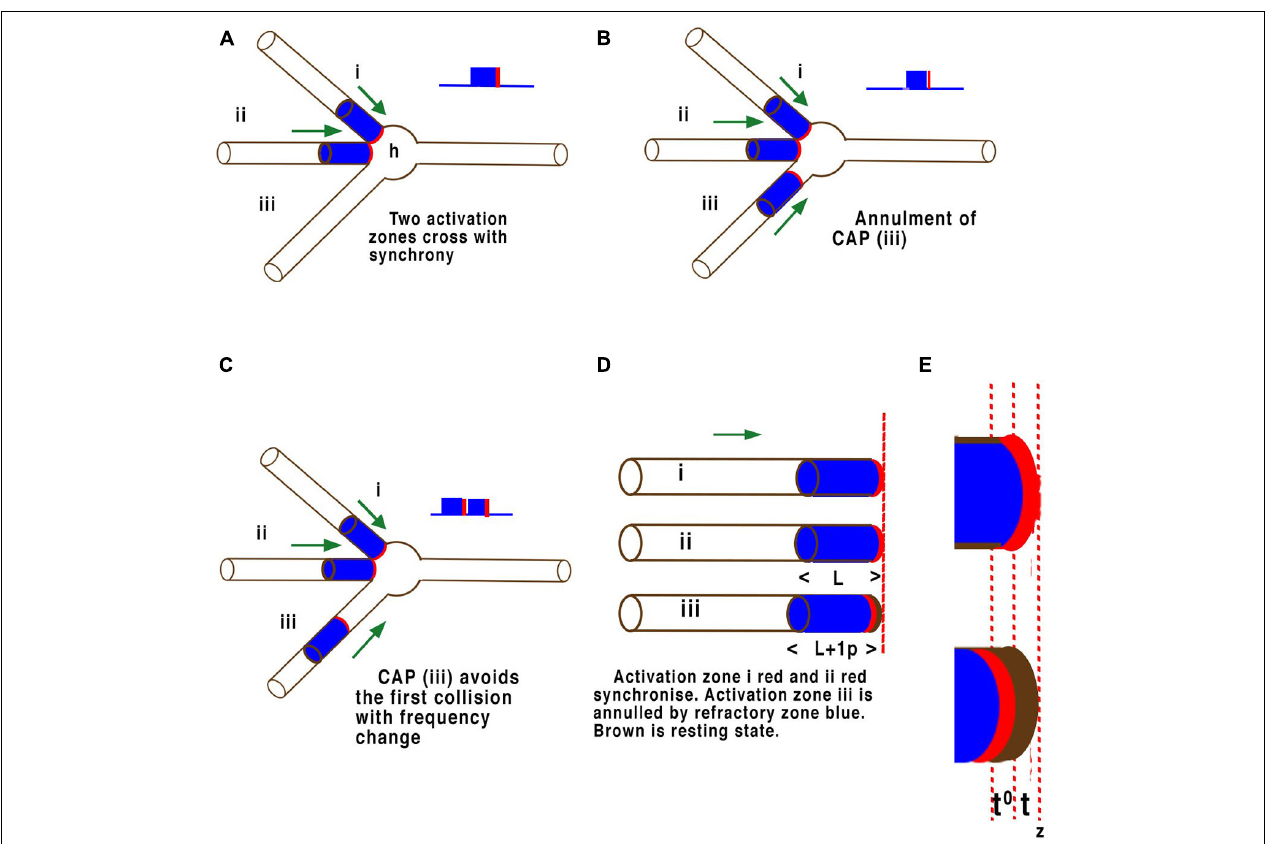
FIGURE 6 | Examples of quantum phase ternary interference between CAPs. Panels (A–E) are illustrations of CAP’s travelling along the surfaces of the neuron membrane just before collisions at the axon hillock (h). The threshold of each CAP is highlighted in red while the refractory period is coloured blue. These are not to scale. Panel (A) illustrates a single neuron with three axons converging on an axon hillock or cell body. Two CAP’s (i) and (ii), move in the direction of the axon hillock where they will collide. In this case both CAP’s (i) and (ii), are in phase with the thresholds overlapping. These CAPs will fuse and continue a single CAP. (B) The same two CAP’s (i) and (ii), are in phase with the thresholds overlapping and will fuse and continue as one CAP as in panel (A) , but a third CAP (iii) arrives slightly after the other two and its threshold encounters the refractory period of the other two and is annulled. (C) The same two CAP’s (i) and (ii), are in phase with the thresholds overlapping. These CAP will fuse and continue as one CAP as before, but in this case the threshold of the third CAP (iii) arrives at the axon hillock after the first two have fused and their respective refractory periods have no effect on it. The result is that two CAPs will pass into the axon at right. In panel (D) (L) represents the refractory time of each CAP, whilst in panel (E) (t) represents the timing of the activation-threshold at (z), the point of computation. In a parallel network (D) where CAP’s converge any time greater than (t) and less than (L) will result in phase change. This phase change changes the distance between successive CAP’s and therefore frequency. Where activation-thresholds become desynchronised phases become